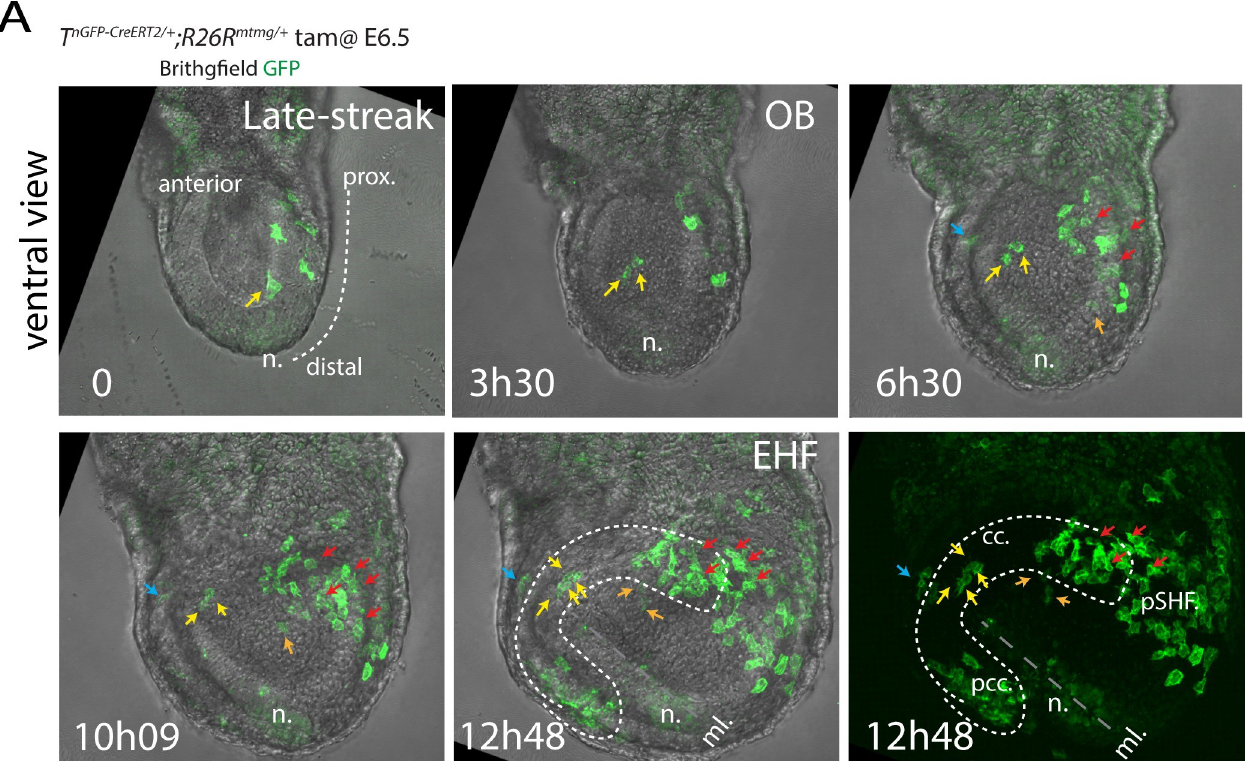
Fig 10. Live imaging of the mesodermal cells reveal their trajectories during gastrulation. (A) Image sequence from time-lapse video (S1 Movie) of an T nGPF-CreERT2/+ ; R26 mgpf/+ embryo resulting from the administration of tamoxifen at around E6.5 (overnight timed matings). Yellow arrows point to progenitor initially located in proximity to the node/distal regions and migrating along the midline in medial regions of the prospective cardiac crescent. Red arrows point to progenitors initially located proximally and migrated towards posterior regions of the prospective cardiac crescent and posterior second heart field. Blue arrow points to a progenitor located at the embryonic-extraembryonic border. Images are z-maximum projection of 37 sections acquired every 5 μ m and covering 185 μ m. Interval between frames: 6 mn and 30 s. cc, cardiac crescent; EHF, early head fold; ml, midline; n, node; OB, no bud; pCC, posterior cardiac crescent; pSHF, posterior second heart field. The movie can be found in S1 Movie.